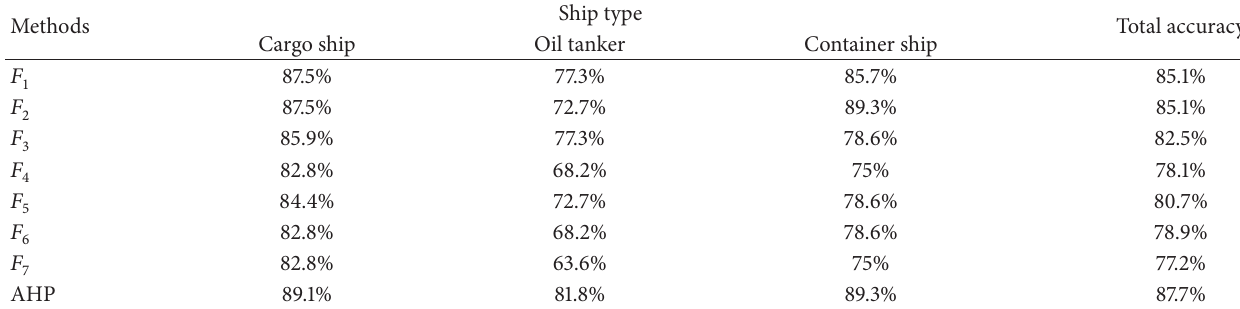
Table 3: Ship classification accuracy based on KNN classifier.